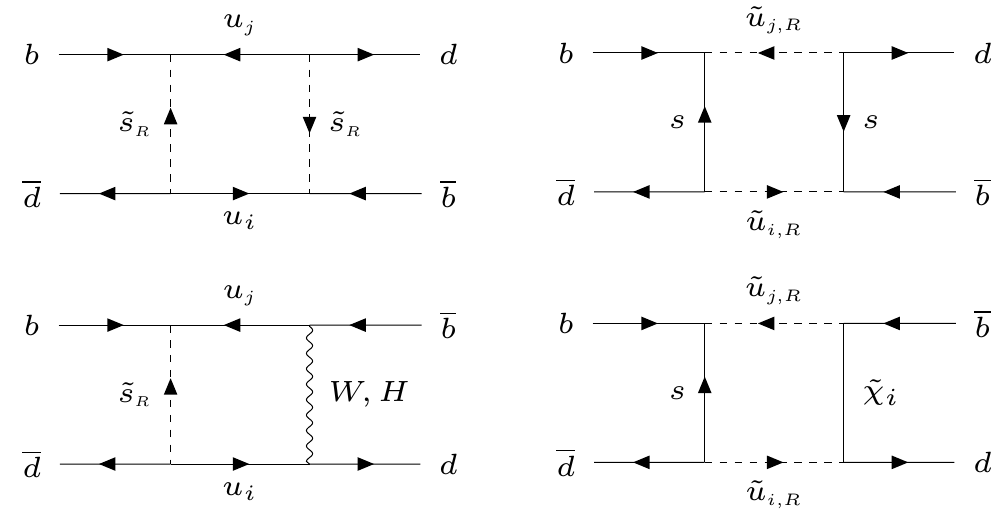
Figure 7. Diagrams involving the RPV couplings (cid:21) 00 ijk and contributing to the neutral meson oscillations. The case of the B 0 system is shown as an example, the K 0 and B 0 are analogous with s d the obvious substitutions. Propagator arrows indicate the (cid:13)ow of baryon number.